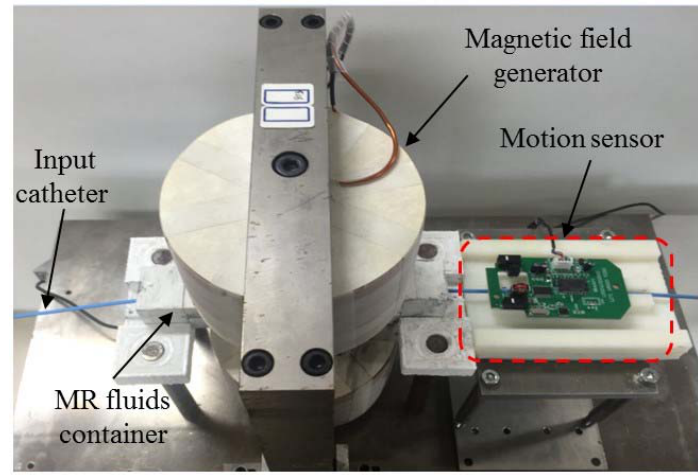
Figure 11. MR fluids actuated catheter haptic master system.